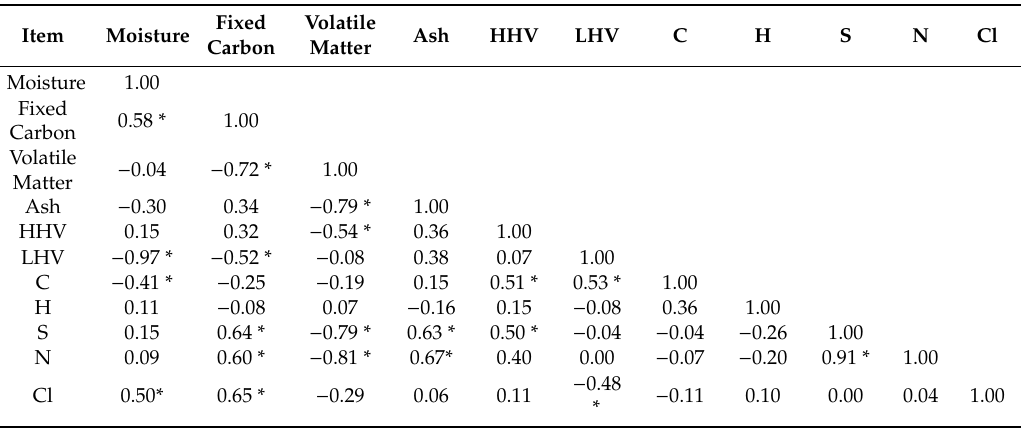
Table 7. Simple correlation coe ffi cient between the analyzed